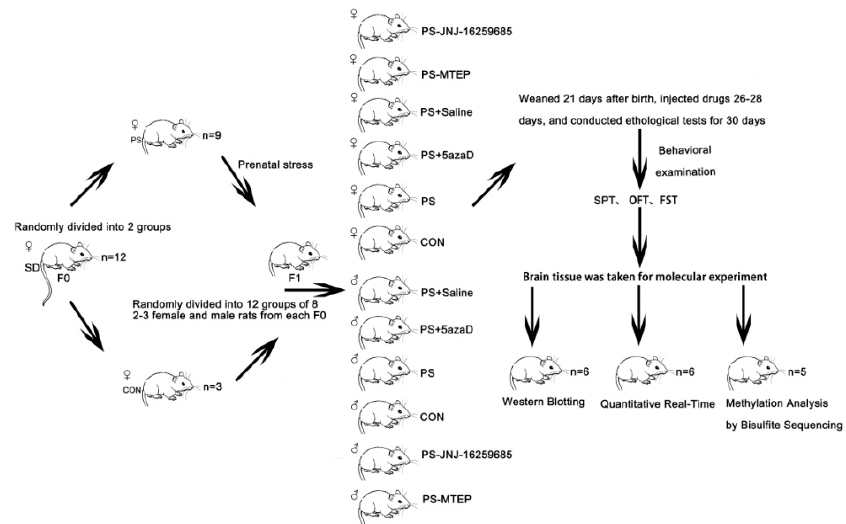
Figure 1. Pregnant rats ( n = 12) randomly divided into two groups the CON ( n = 3) and the PS group ( n = 9). After the offspring were weaned on postnatal day the OR randomly divided into 12 groups ( n = 8), female and male respectively. At 30 days after birth, depression-like behavior was assessed by the SPT, FST, and OFT ( n = 8 each group). Then, the mRNA and protein expression levels ( n = 6 each group) and the promoter methylation ( n = 5 each group) of mGluR1 and mGluR5 in the OR hippocampus were evaluated.